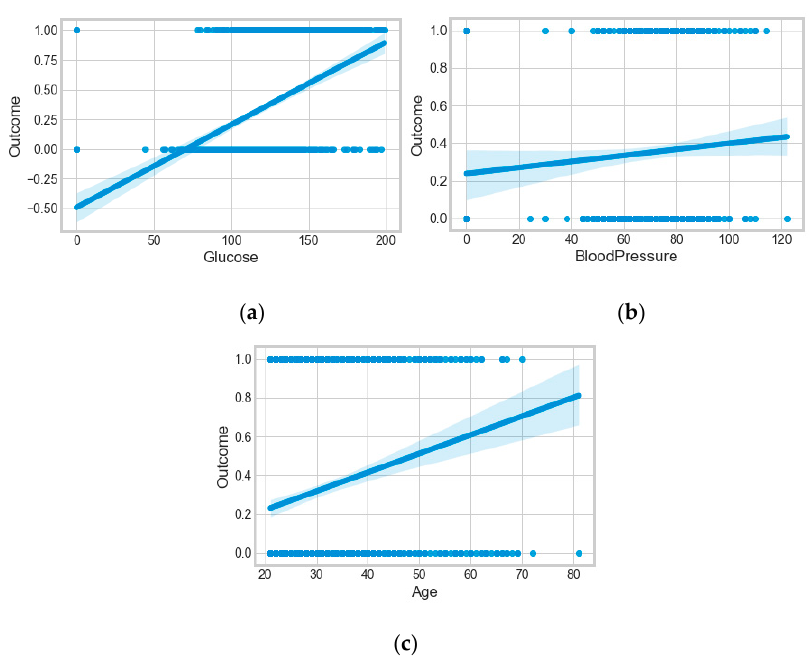
Figure 15. ( a ) Relationship of the outcome (obesity) with blood glucose; ( b ) relationship of the outcome (obesity) with blood pressure; ( c ) relationship of the outcome (obesity) with age.